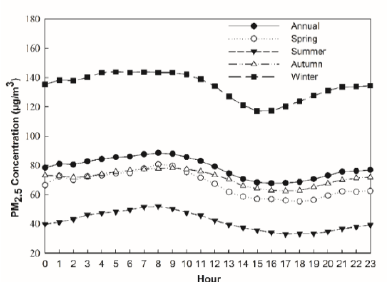
Figure1 Diurnal Variation of PM 2.5 Concentration in Different Seasons in Zhengzhou during 2016